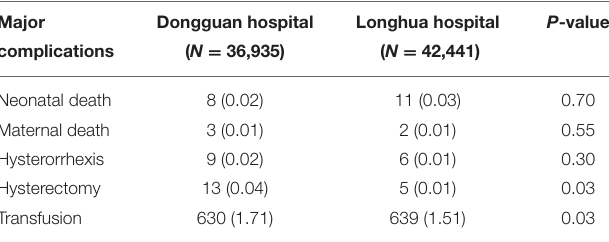
TABLE 5 | Comparison between two study hospitals in women and neonatal complications.